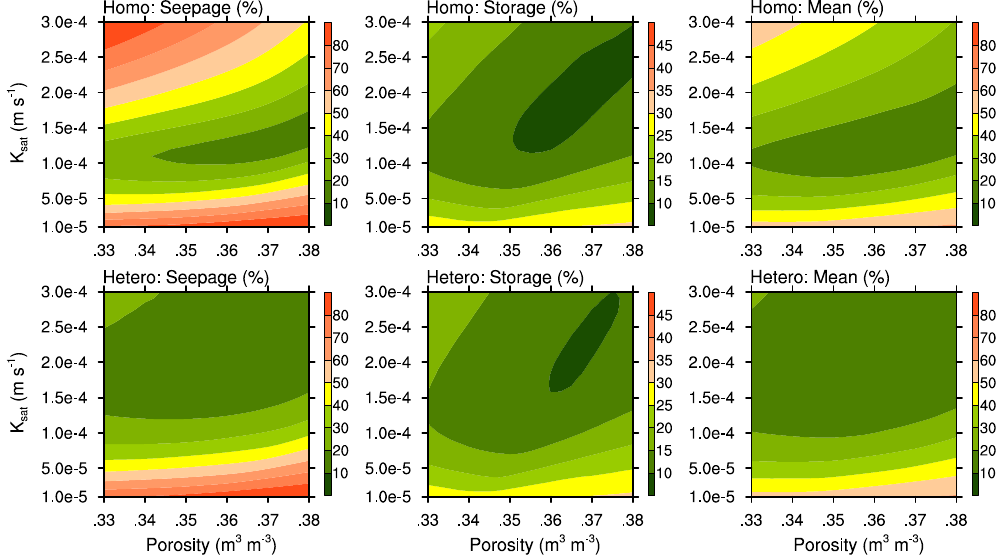
Figure 5. Relative model error ( e ) of seepage flow and water storage and the mean error for M3_Homo (upper panels) and M3_Hetero (lower panels; with K sat,sf =2.1 × 10 − 5 ms − 1 ) over the parameter space of K sat and